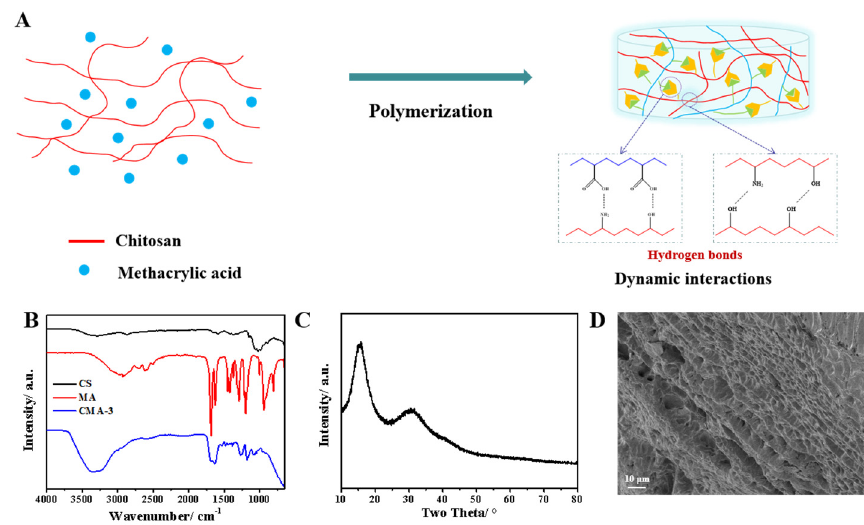
Figure 1. ( A ) Preparation of CMA hydrogels. ( B ) FTIR spectra of CS, MA and CMA-3 hydrogels. ( C ) XRD pattern of CMA-3 hydrogel. ( D ) SEM image of CMA-3 hydrogel.